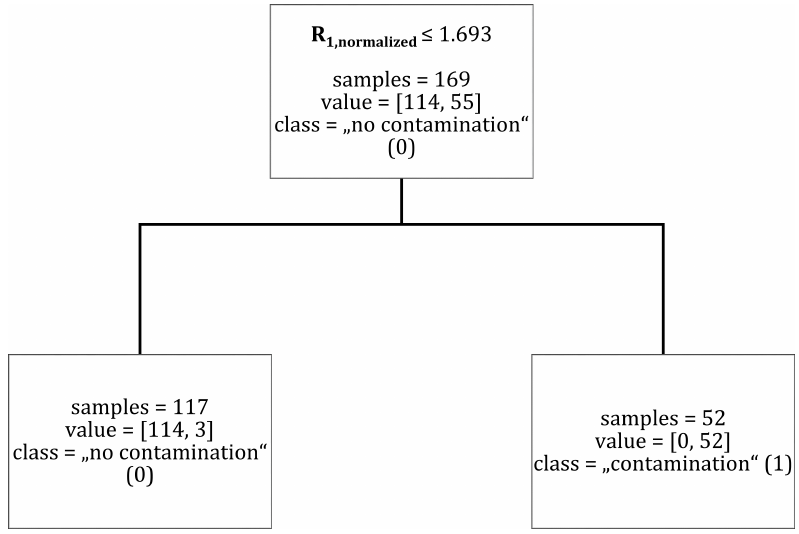
Figure A2. Classification of data points into the classes “no contamination” (0) and “contamination” (1) for a decision tree with tree depth = 1. Brackets indicate (“no contamination” (0), “contamination” (1)).